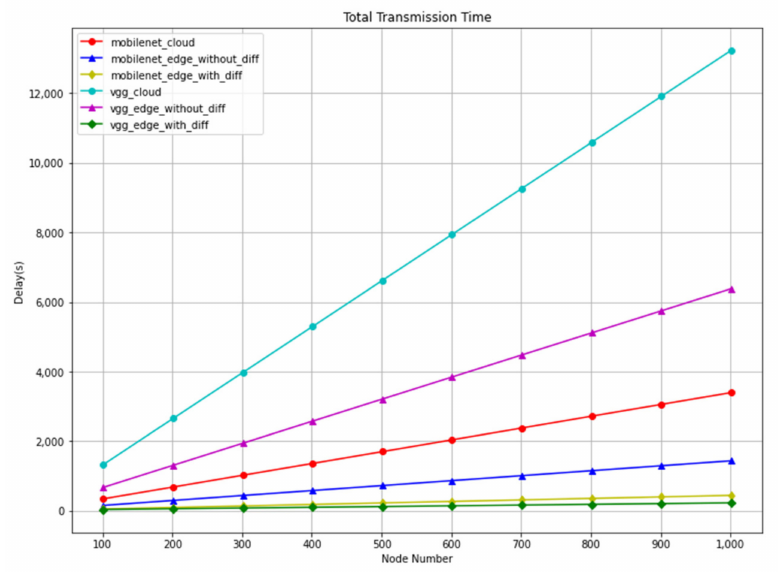
Figure 8. The simulation results of the proposed collaborative edge computing